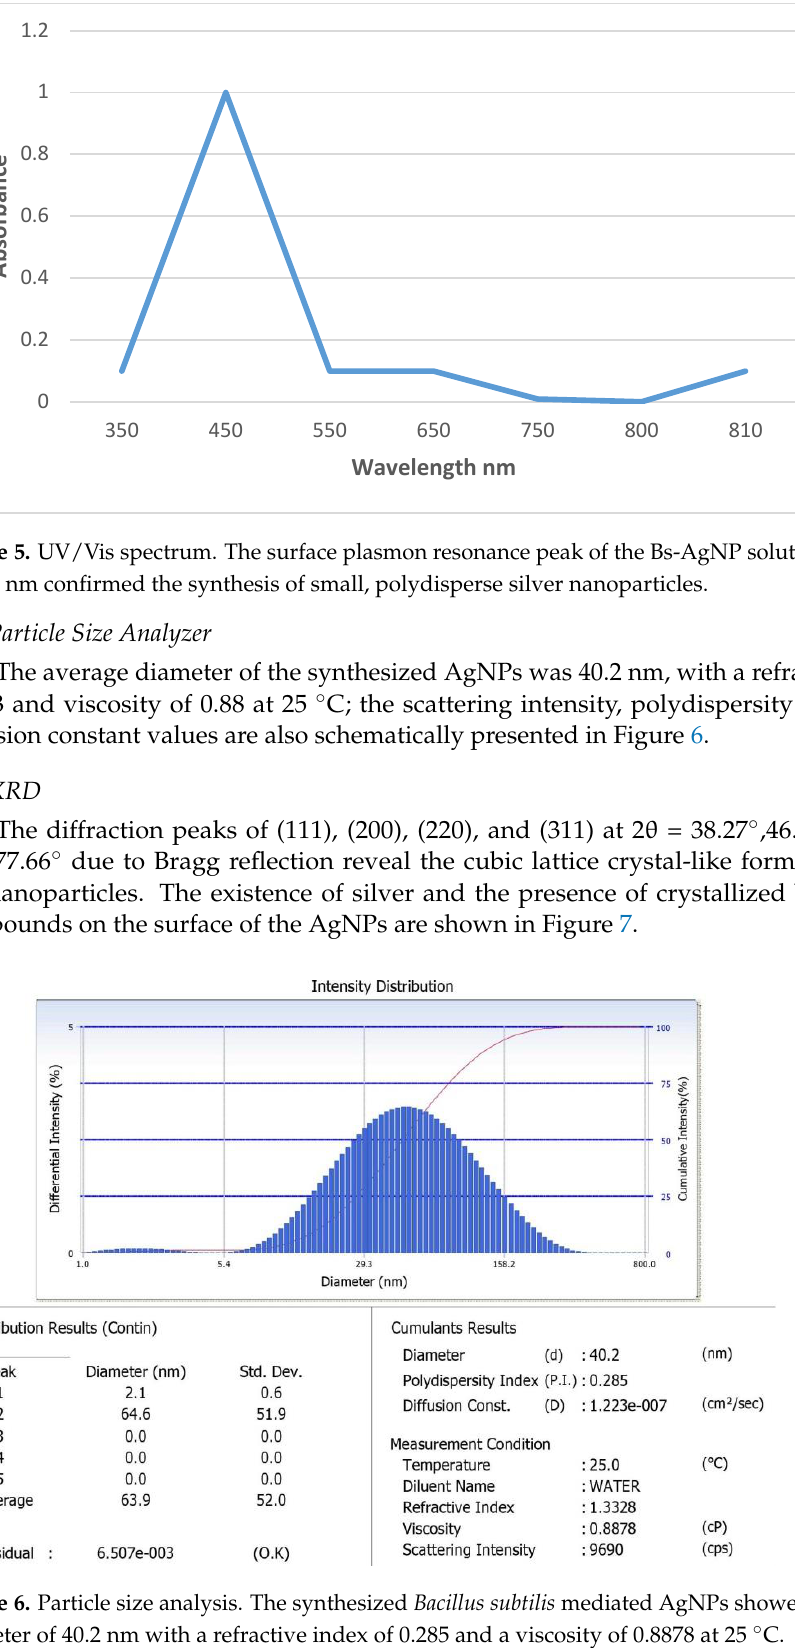
Figure 6. Particle size analysis. The synthesized Bacillus subtilis mediated AgNPs showed an average diameter of 40.2 nm with a refractive index of 0.285 and a viscosity of 0.8878 at 25 °C.